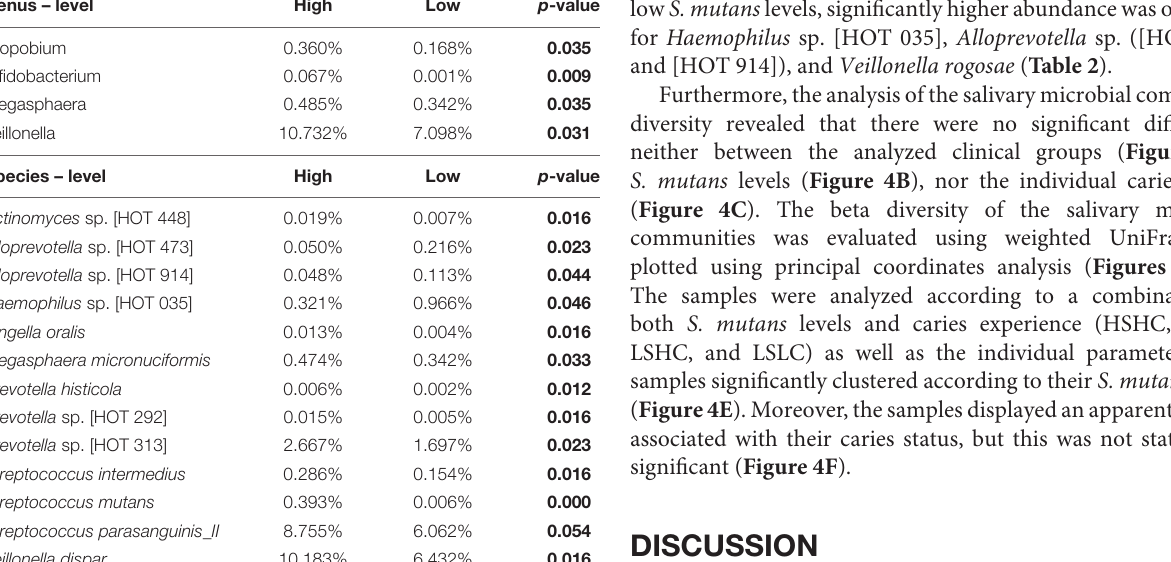
Frontiers in Microbiology |